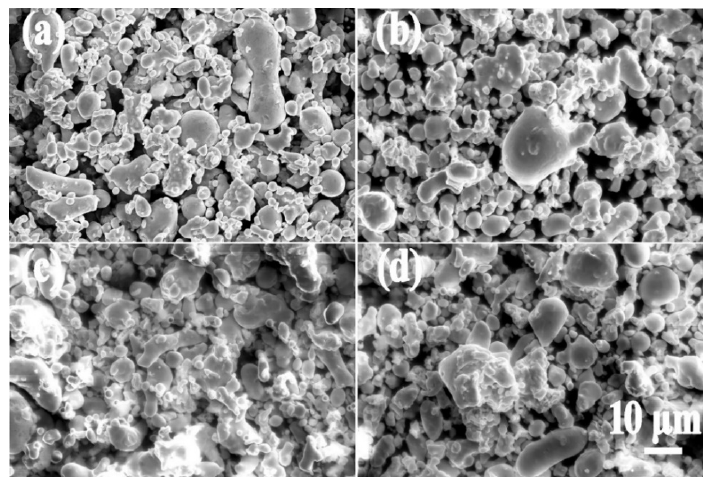
Figure 6. Fe-Si-Cr powders coated with PI: ( a ) 0 wt% PI, ( b ) 0.4 wt% PI, ( c ) 0.7 wt% PI, ( d ) 1.0 wt% PI.